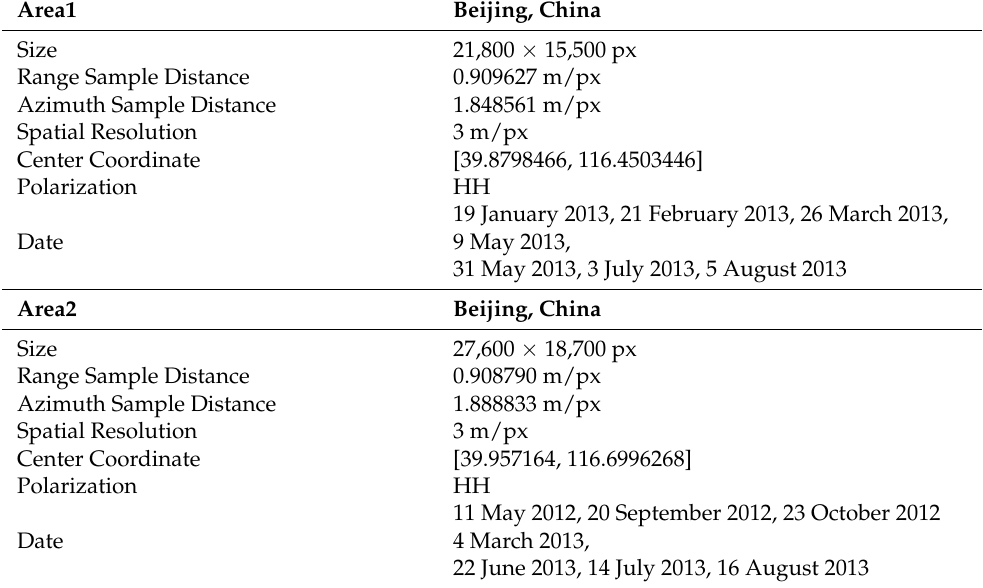
Table 1. Metadata of the TerraSAR-X Images Used in Our Data